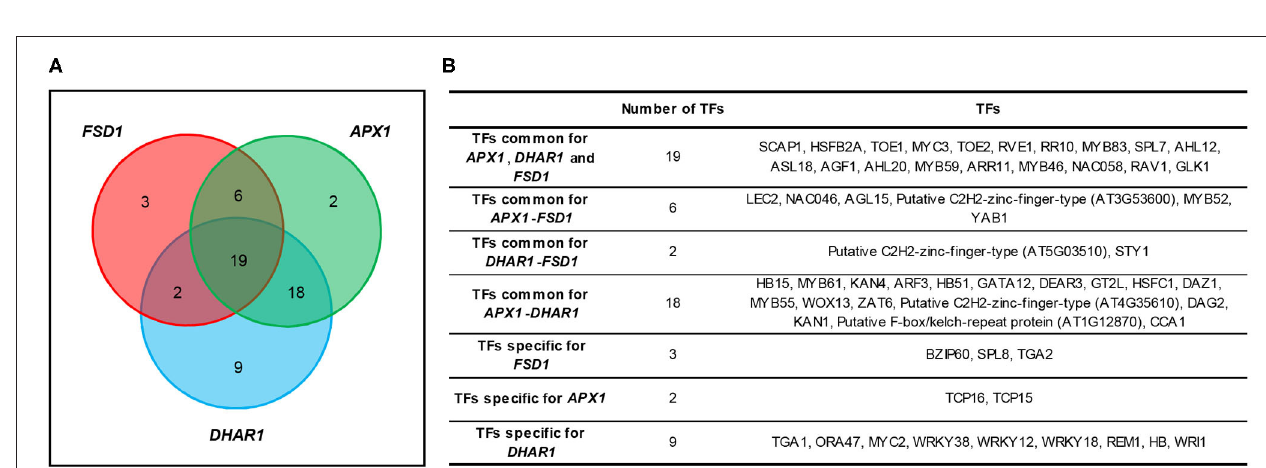
FIGURE 2 | Graphical (A) and tabular (B) overview of common transcription factors (TFs) predicted to regulate the expression of FSD1 , APX1 , and DHAR1 under the regulation of mitogen-activated protein